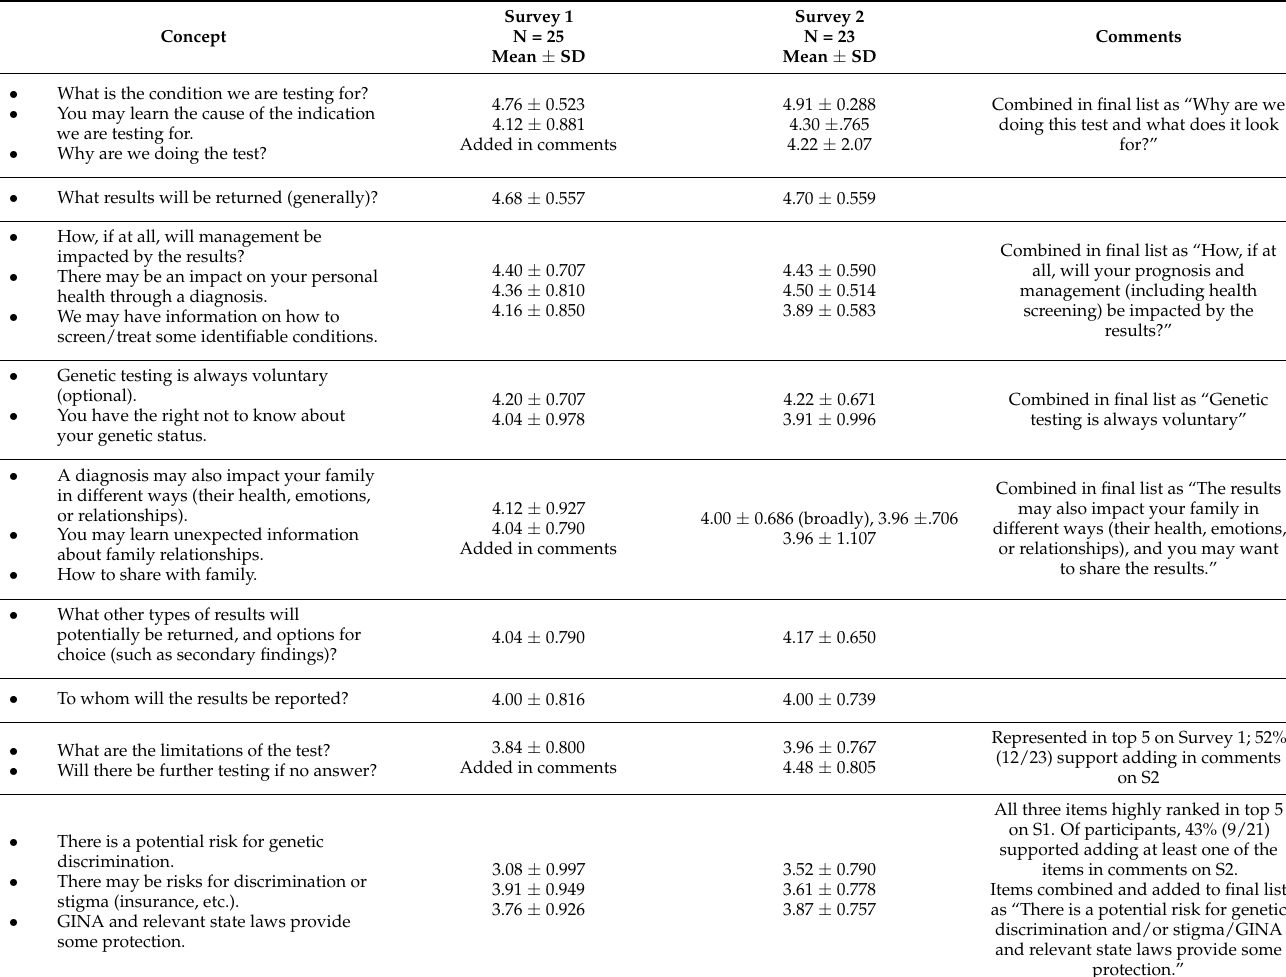
Table 2. Most highly ranked concepts from the consensus